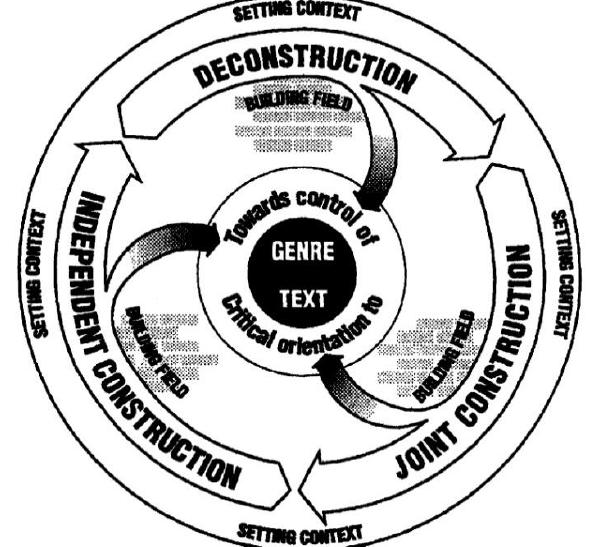
Figure 1 . The teaching-learning cycle (adopted from Martin,